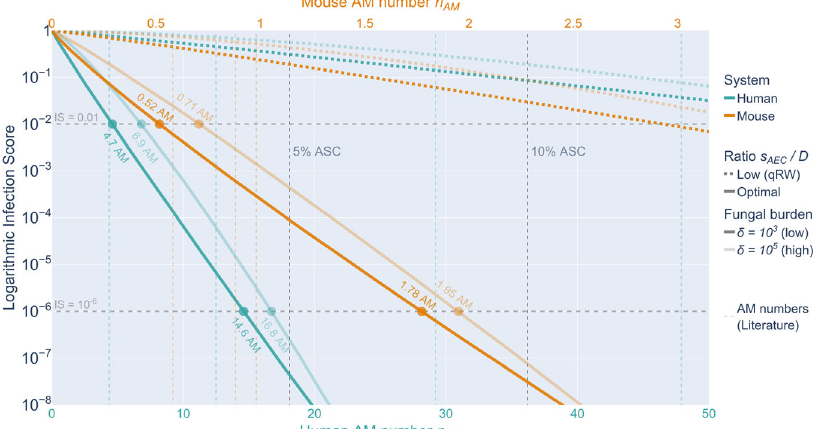
Fig. 7 SIM predictions of infection scores. Log-scaled infection score for quasi-random walk qRW (dotted curves) and optimal ratio s AEC = D (solid curves) in the case of low (dark colors) and high (bright colors) fungal burden in the human (green) and murine (orange) alveolus. Colored dashed vertical lines represent the corresponding AM numbers as obtained by literature data. Black dashed vertical lines denote the 5% and 10% ASC for both